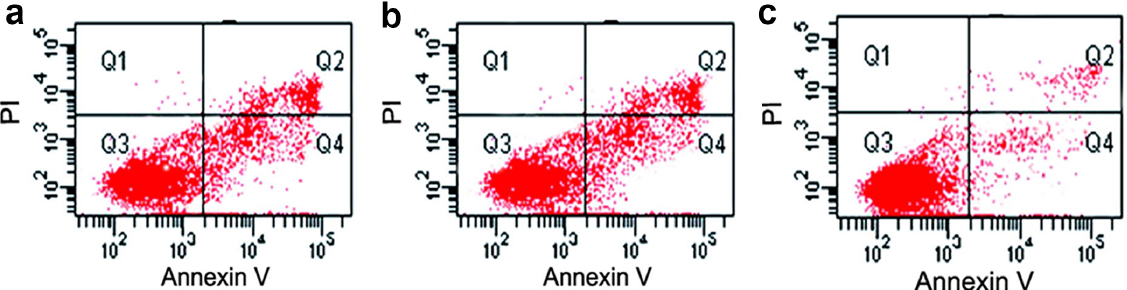
Figure 6. Flow cytometric analyses utilizing Annexin-V-FITC of ( a ) control locusts, ( b ) Al 2 O 3 NPs- treated locusts, and ( c ) locusts treated with PAE + Al 2 O 3 NPs. Q1, Q2, Q3, and Q4 signify necrotic cells, late apoptotic cells, viable cells, and early apoptotic cells, respectively.